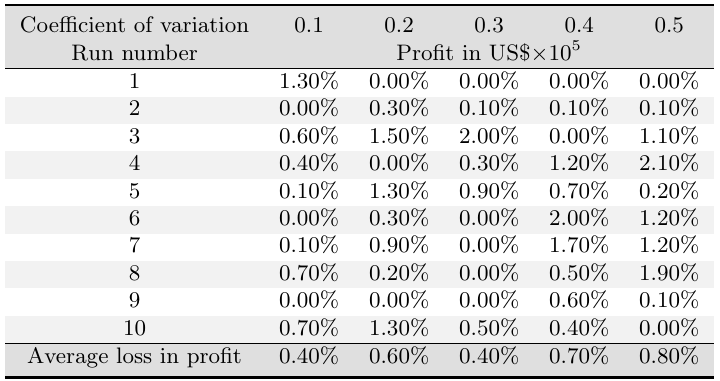
Table 11 shows the change in profit of a fixed trawler schedule as opposed to free trawler schedules for 10 runs for each coefficient of variation. The total profit decreases by 0.4%, 0.6%, 0.4%, 0.7% and 0.8%, respectively, for different coefficients of variation. The average loss in profit is 0.58%.